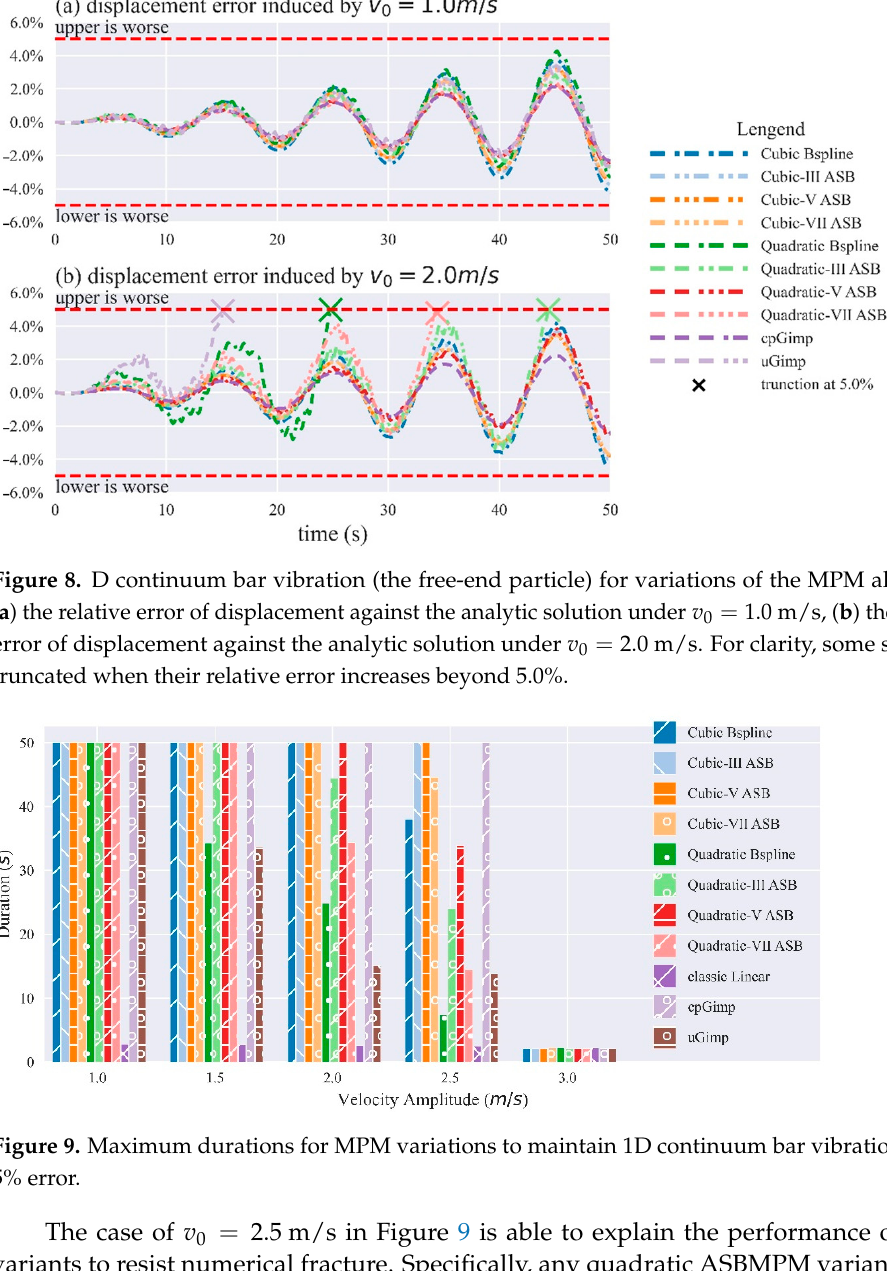
Figure 9. Maximum durations for MPM variations to maintain 1D continuum bar vibration within 5% error.